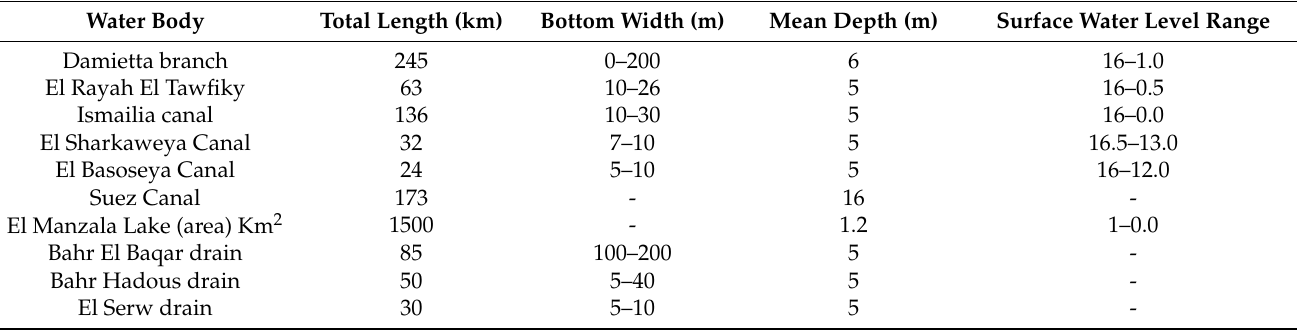
Table 1. The main water bodies in the ENDA